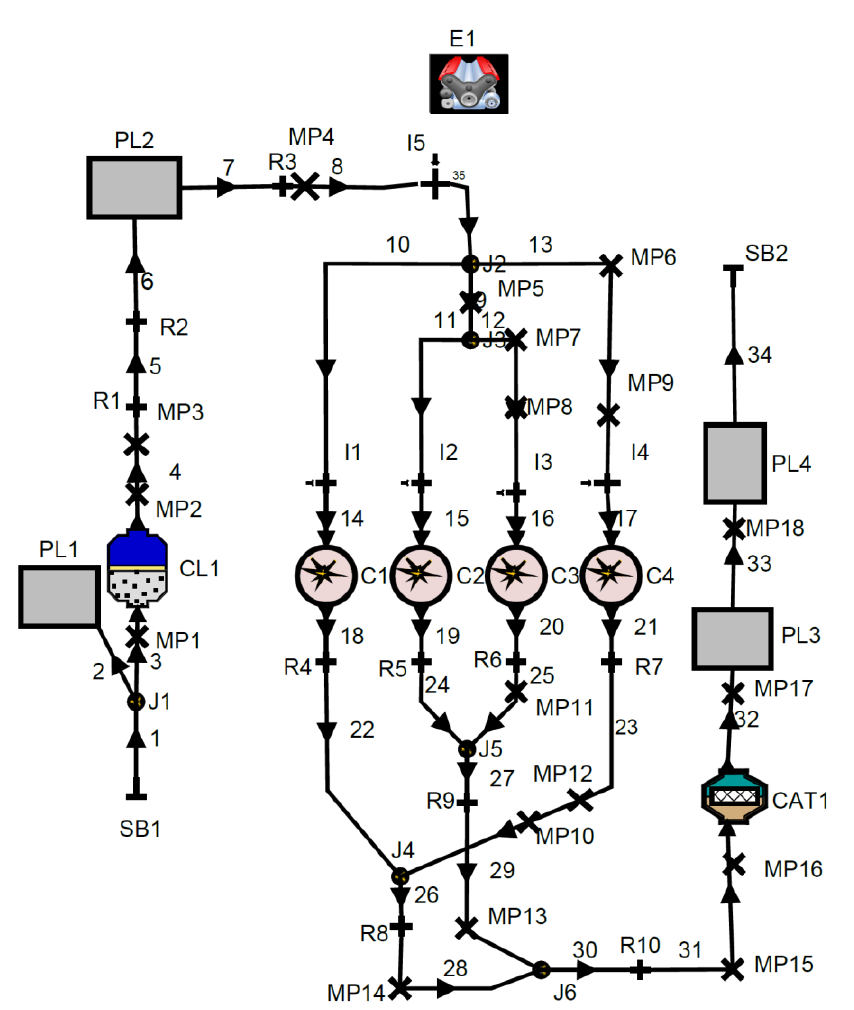
Figure 2. Block diagram of engine model in AVL BOOST software.